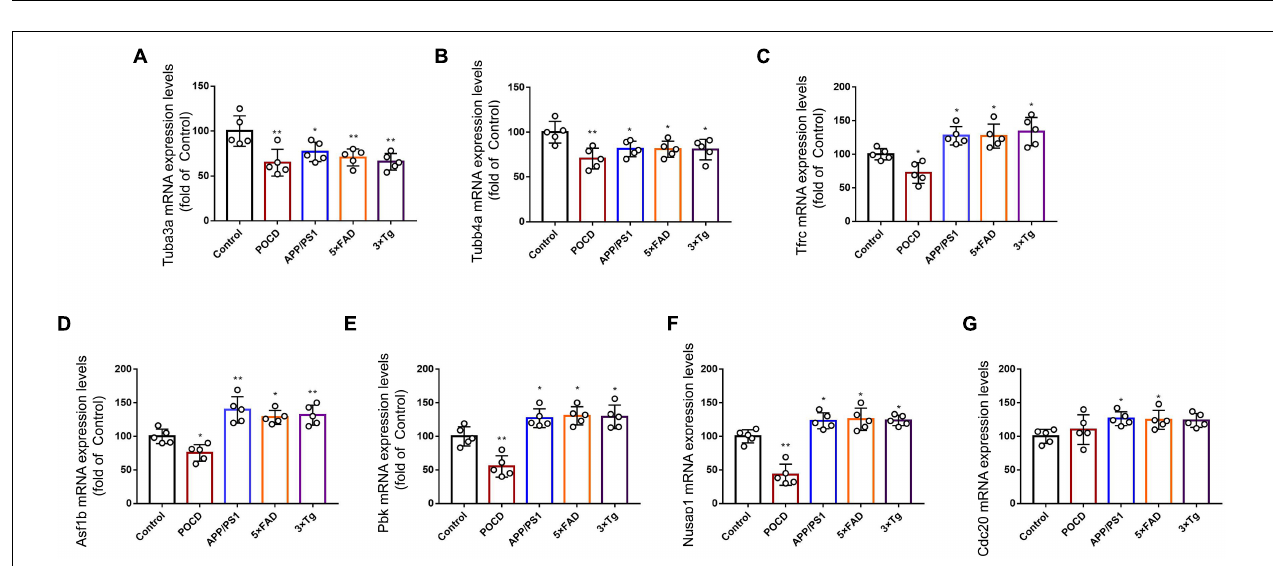
FIGURE 8 | Expression levels of (A) Tuba3a , (B) Tubb4a , (C) Tfrc , (D) Asf1 , (E) Pbk , (F) Nusap1 , and (G) Cdc20 mRNA detected by qPCR in control, POCD, and AD groups. All experiments were repeated three times. * p < 0.05, ** p < 0.01 vs. control group. The data are presented as the mean ± SEM ( n = 5).